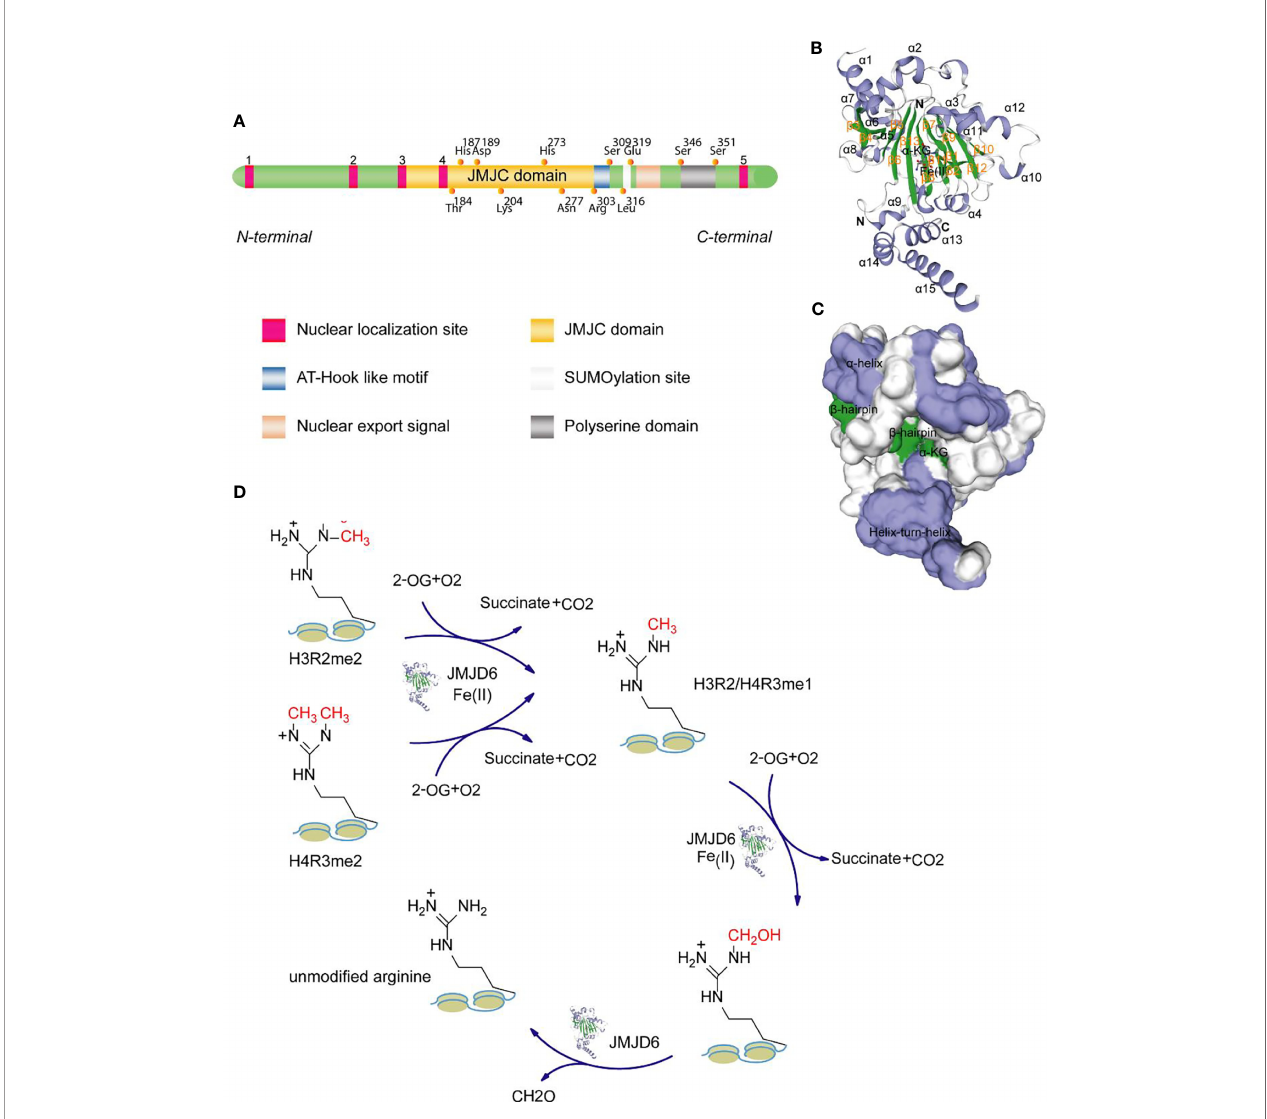
FIGURE 1 | Domain structure of JMJD6 protein. (A) JMJD6 protein mainly consists of one JMJC domain, fi ve nuclear localization sites, one AT-Hook domain, one presumed SUMOylation site, and one polyserine domain. (B) The stereo view of JMJD6 (PDB code: 6MEV) structure with a -KG and Fe (II) showing a -helix, b -hairpin, N-terminal domain and C-terminal domain. (C) The surface potentials of JMJD6 protein. The positively charged surface is grayish white, the negatively charged surface appears blue, and the surface of the neutral charge is green. The above two 3D views are drawn with the SWISS-MODEL software (11). (D) Schematic diagram showing the mechanisms for the demethylase activity of